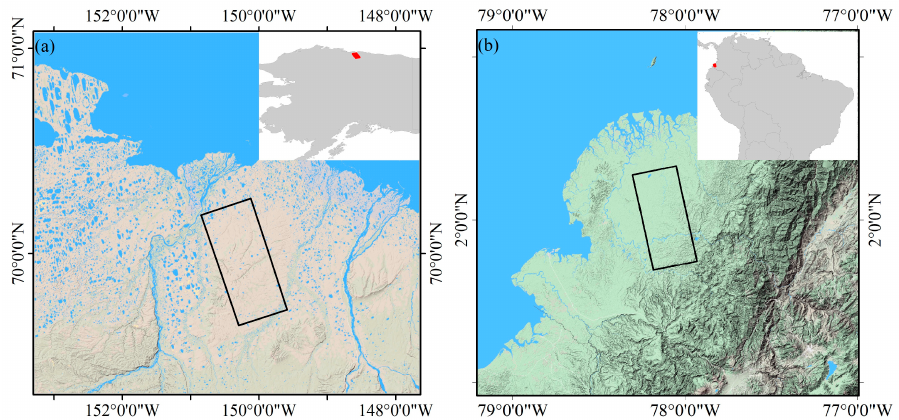
Figure 1. The coverage and map projection of PALSAR images to be presented in our study for ionospheric phase compensation at ( a ) Alaska and ( b ) Equator.